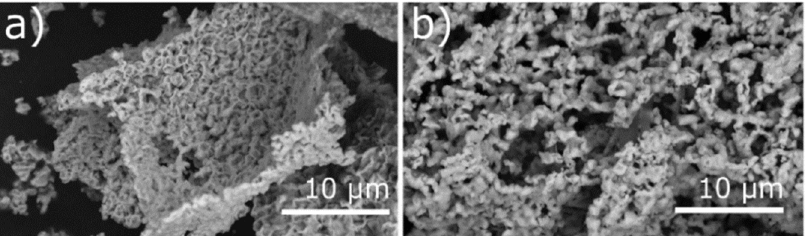
Figure 2. SEM images of ( a ) Cu-a and ( b ) Cu-c. Cu-a shows a frilled and compact CuO structure obtained from CuNP precursor, and Cu-c shows large pores and a less dense ordered structure from CuO as precursor.